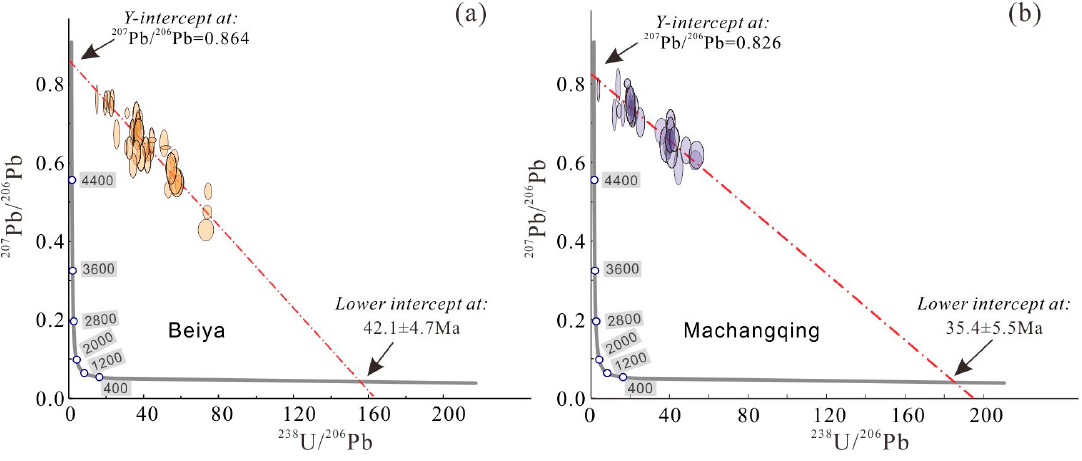
Figure 9. Laser ablation-inductively coupled plasma-mass spectrometry (LA-ICP-MS) Tera-Wasserburg diagram: ( a ) the Beiya deposit; and ( b ) the Machangqing deposit.